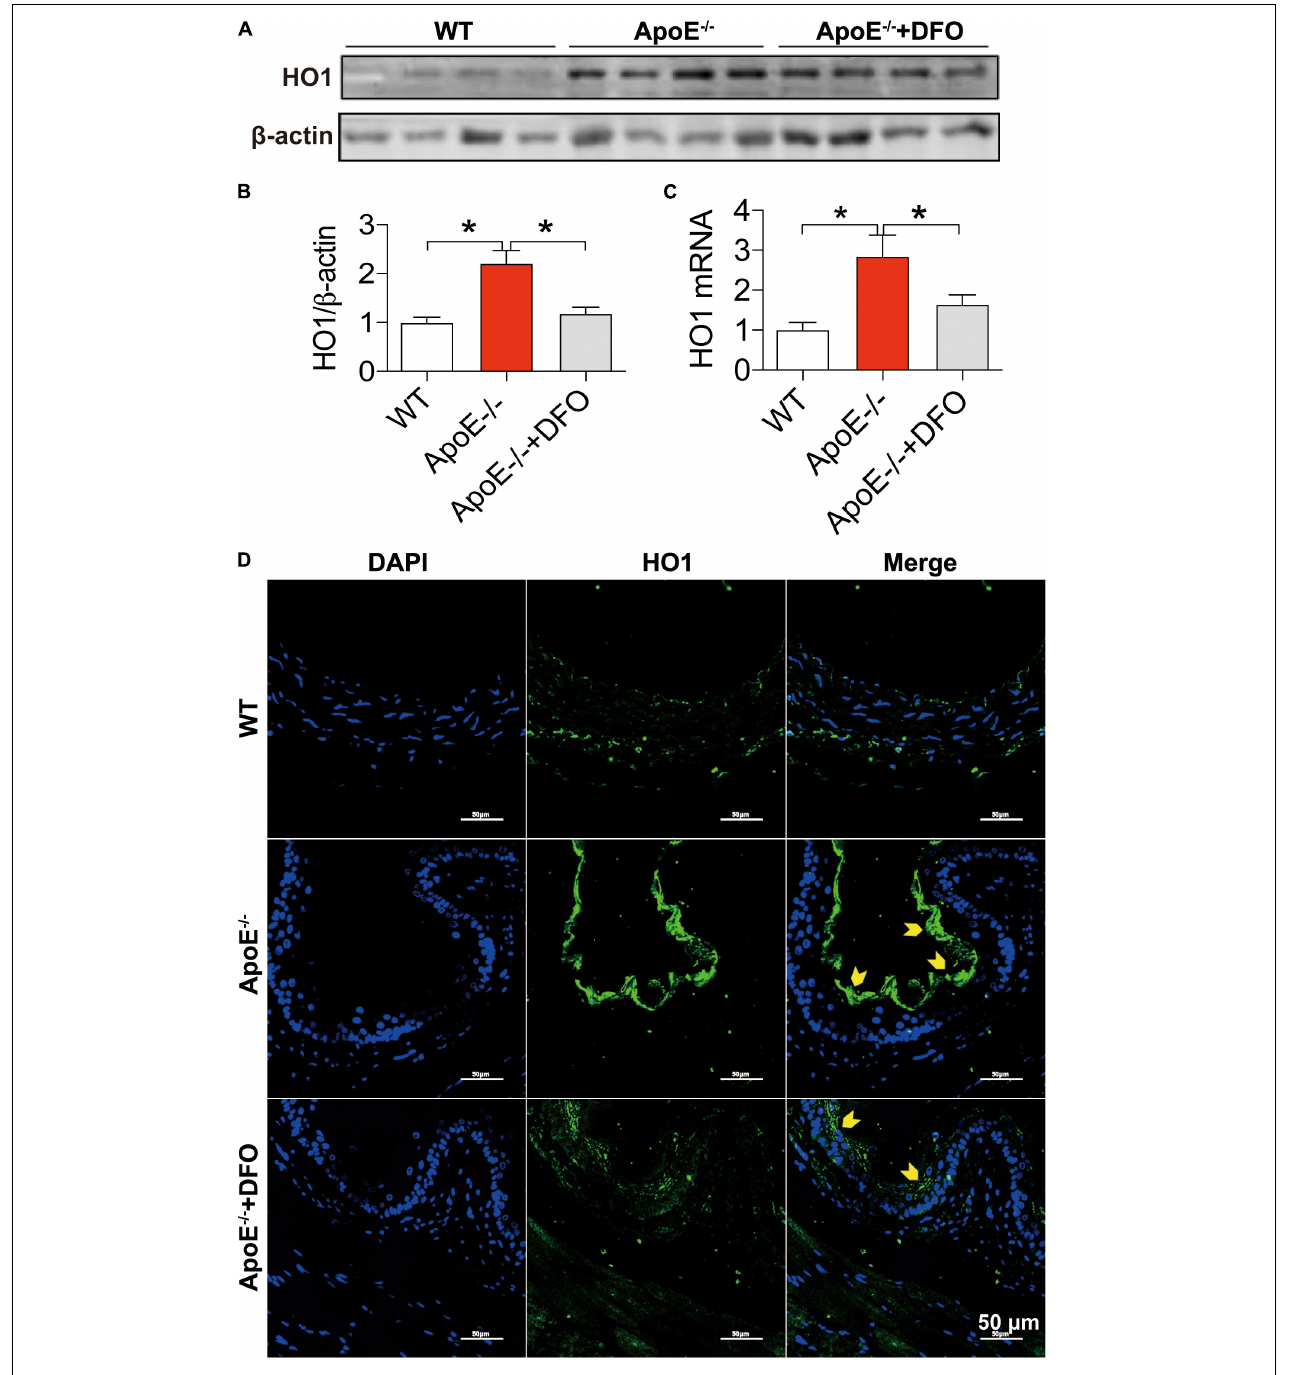
FIGURE 4 | ApoE deficiency up-regulated HO1 expression in the aortic tissues. The expression of HO1 protein and mRNA in the aortic tissues were, respectively, determined by Western blot (A,B) , RT-PCR (C) or/and immunofluorescence (D) analysis as described in section “Materials and Methods” in WT ( n = 8; WB: n = 4), ApoE – / – ( n = 8; WB: n = 4) and ApoE – / – + DFO ( n = 8; WB: n = 4) mice, all aged 28 week-old. The mice in ApoE – / – + DFO group received daily i.p. injections of 100 mg/kg body weight (b.w.) of DFO in HBSS for 14 days. Scale bar in panel (D) = 50 µ m. Data are presented as the mean ± SEM. * p <